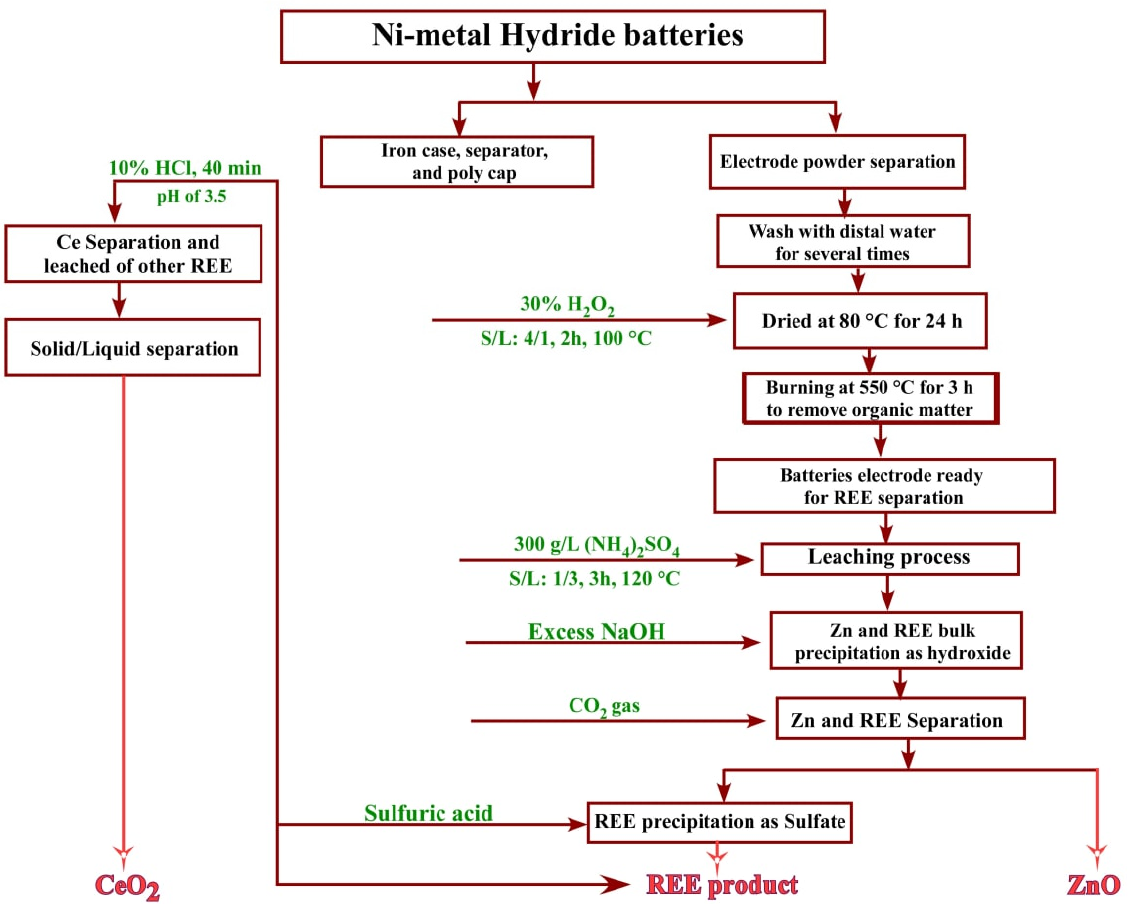
Figure 17. Flowsheet for the recovery of REEs from Ni–metal hydride batteries.